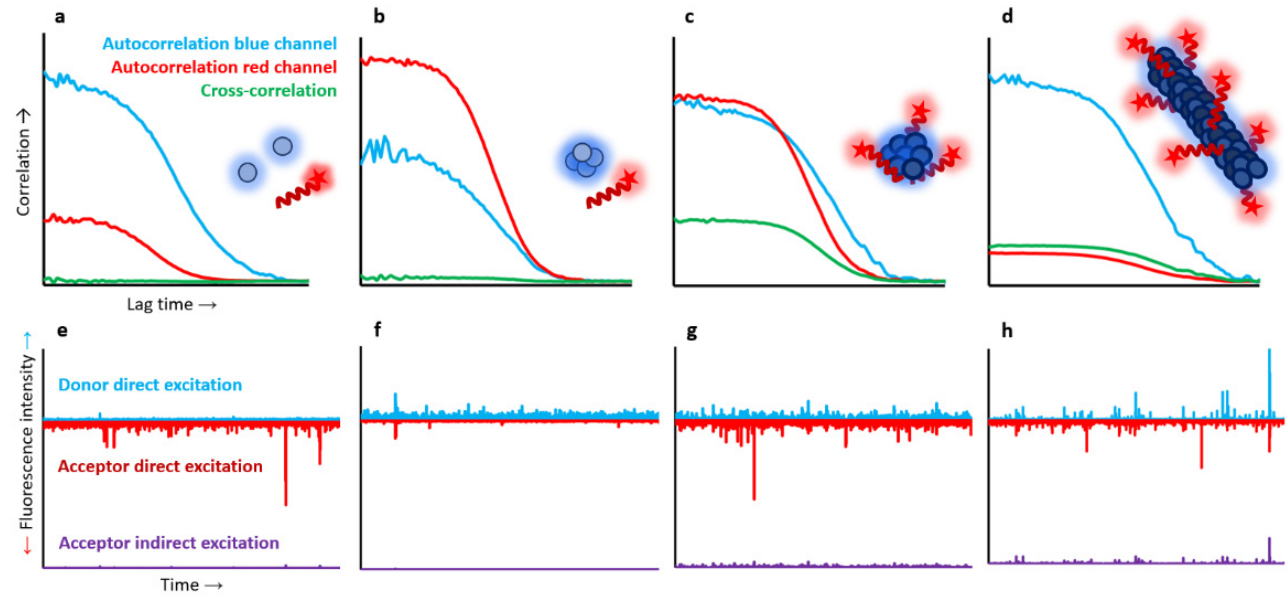
Figure 4. Detailed analysis of the interaction of a peptide molecule with structurally distinct α S species by diffusion-based single-molecule fluorescence techniques. ( a – d ) Representative autocorrelation curves for AF488- α S (blue line) and Atto647N-peptide (red line) and cross-correlation curves for the interacting molecules (green line). ( e – h ) Representative time traces for direct excitation of the donor ( α S, blue trace), direct excitation of the acceptor (peptide, red trace) and indirect excitation of the acceptor through FRET (purple trace). Samples contained α S monomers ( a , e ), BOs ( b , f ), TOs ( c , g ) or sonicated fibrils ( d , h ). Adapted from Santos, J.; et al. A-Helical Peptidic Scaffolds to Target a-Synuclein Toxic Species with Nanomolar Affinity. Nat Commun 2021, 12 , doi:10.1038/S41467-021-24039-2, published under Creative Commons Attribution 4.0 International (CC BY 4.0) [66].